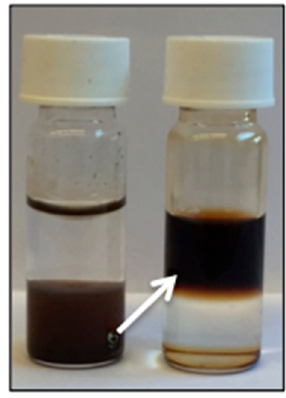
Figure 5. A phase transfer from the organic lower phase to the aqueous upper phase is observed after functionalization with PEG, confirming a successful ligand exchange.